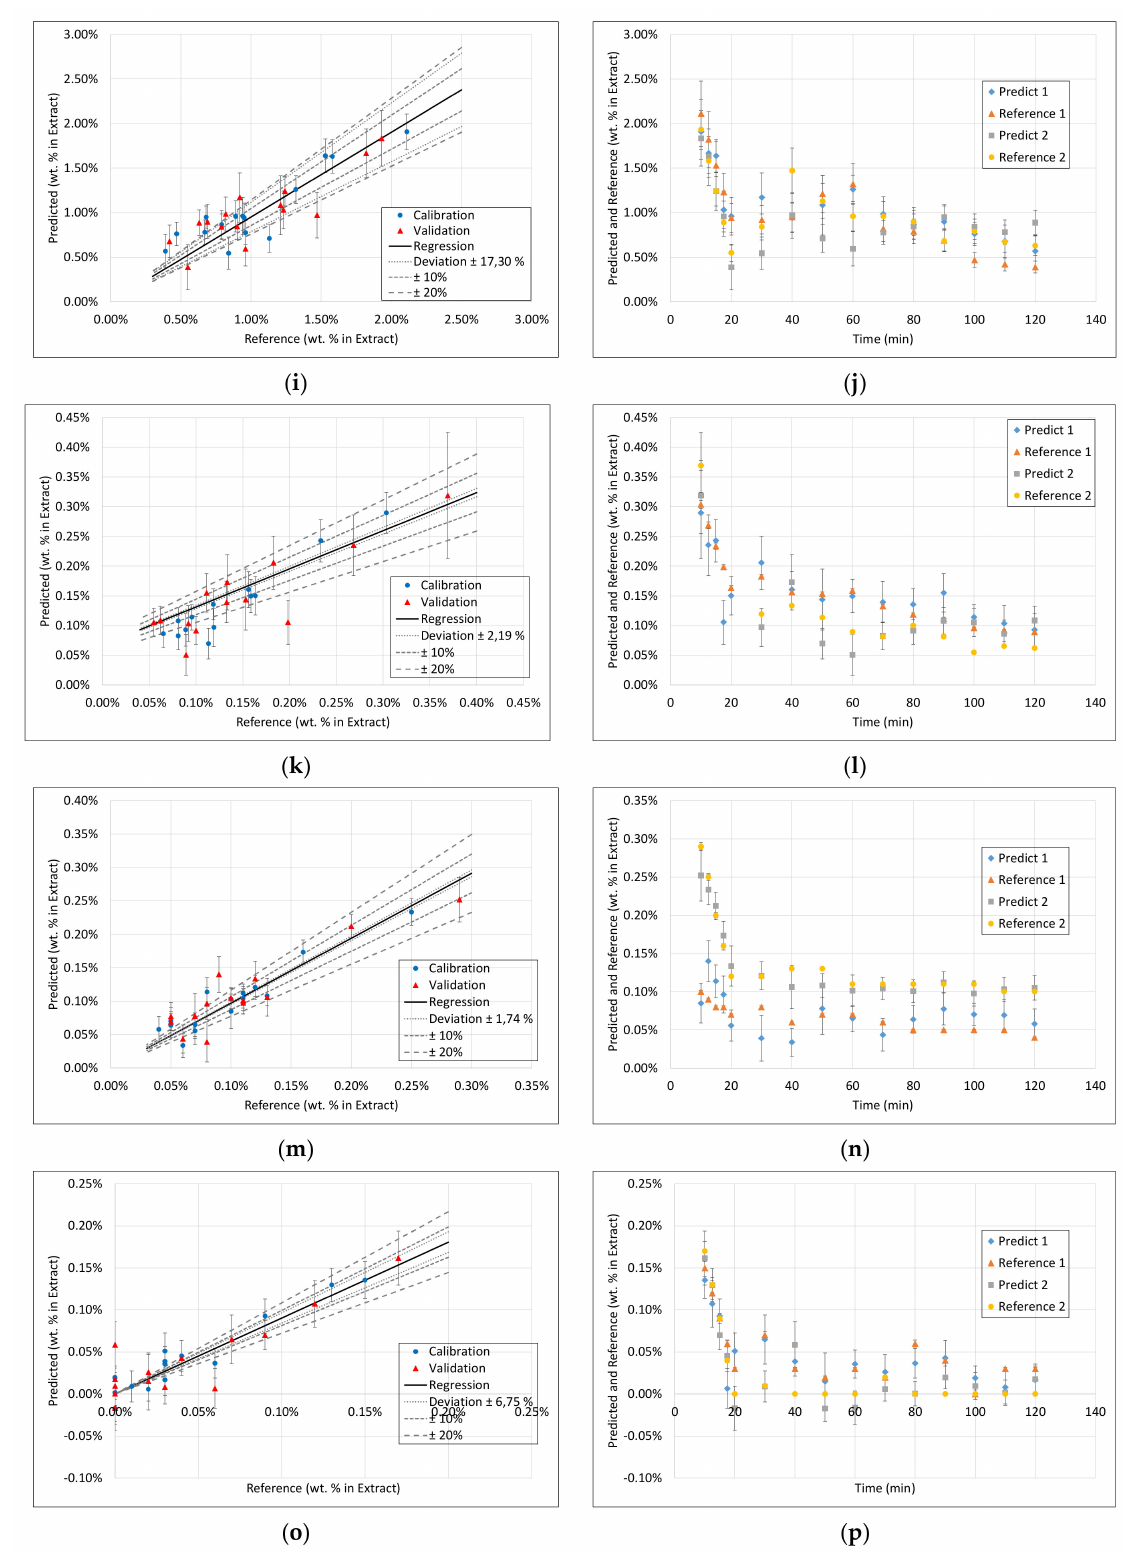
Figure A2. Raman half-normal plots and measured vs. predicted extraction profiles for ( a , b ) dry residue, ( c , d ) arbutin, ( e , f ) total phenolic content, ( g , h ) sugar monomers, ( i , j ) structural carbohydrates, ( k , l ) aminic acids, ( m , n ) proteins, and ( o , p )